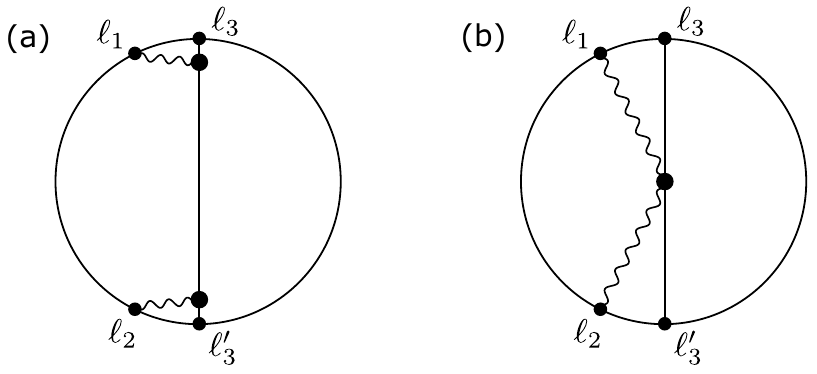
Figure 8 . Illustration of our “time” locality criterion. We consider a field-field-worldline interaction in the limit of large “time” separation | τ between ‘ and ‘ . If the interaction is local, i.e. 1 − τ 2 | 1 2 decays exponentially with the distance ∆ τ along the geodesic, the diagram will exponentially decay with | τ . This can happen through some combination of the scenarios in panels (a), (b). 1 − τ 2 | In panel (a), the diagram is dominated by contributions with ∆ τ ≈ | τ , and is governed 1 − τ 2 | by the interaction’s decay with ∆ τ . In panel (b), the diagram is dominated by contributions with ∆ τ = O (1) , and its exponential decay in | τ is due to the “long” boundary-bulk propagators. 1 − τ 2 |